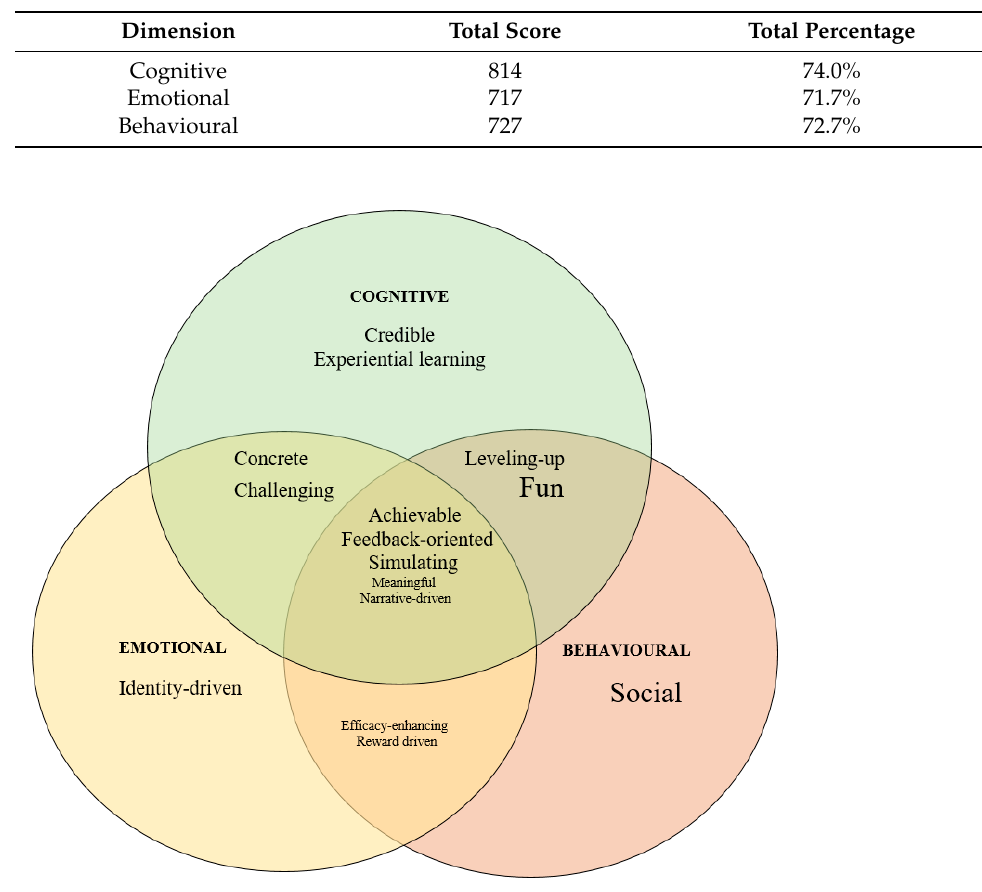
Figure 4. Results Figure 4. Results summary.